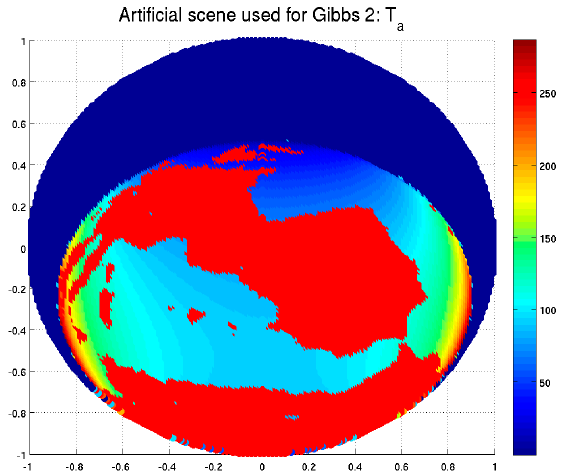
Figure 10. Artificial scene of one SMOS observation of the Iberian peninsula and northern